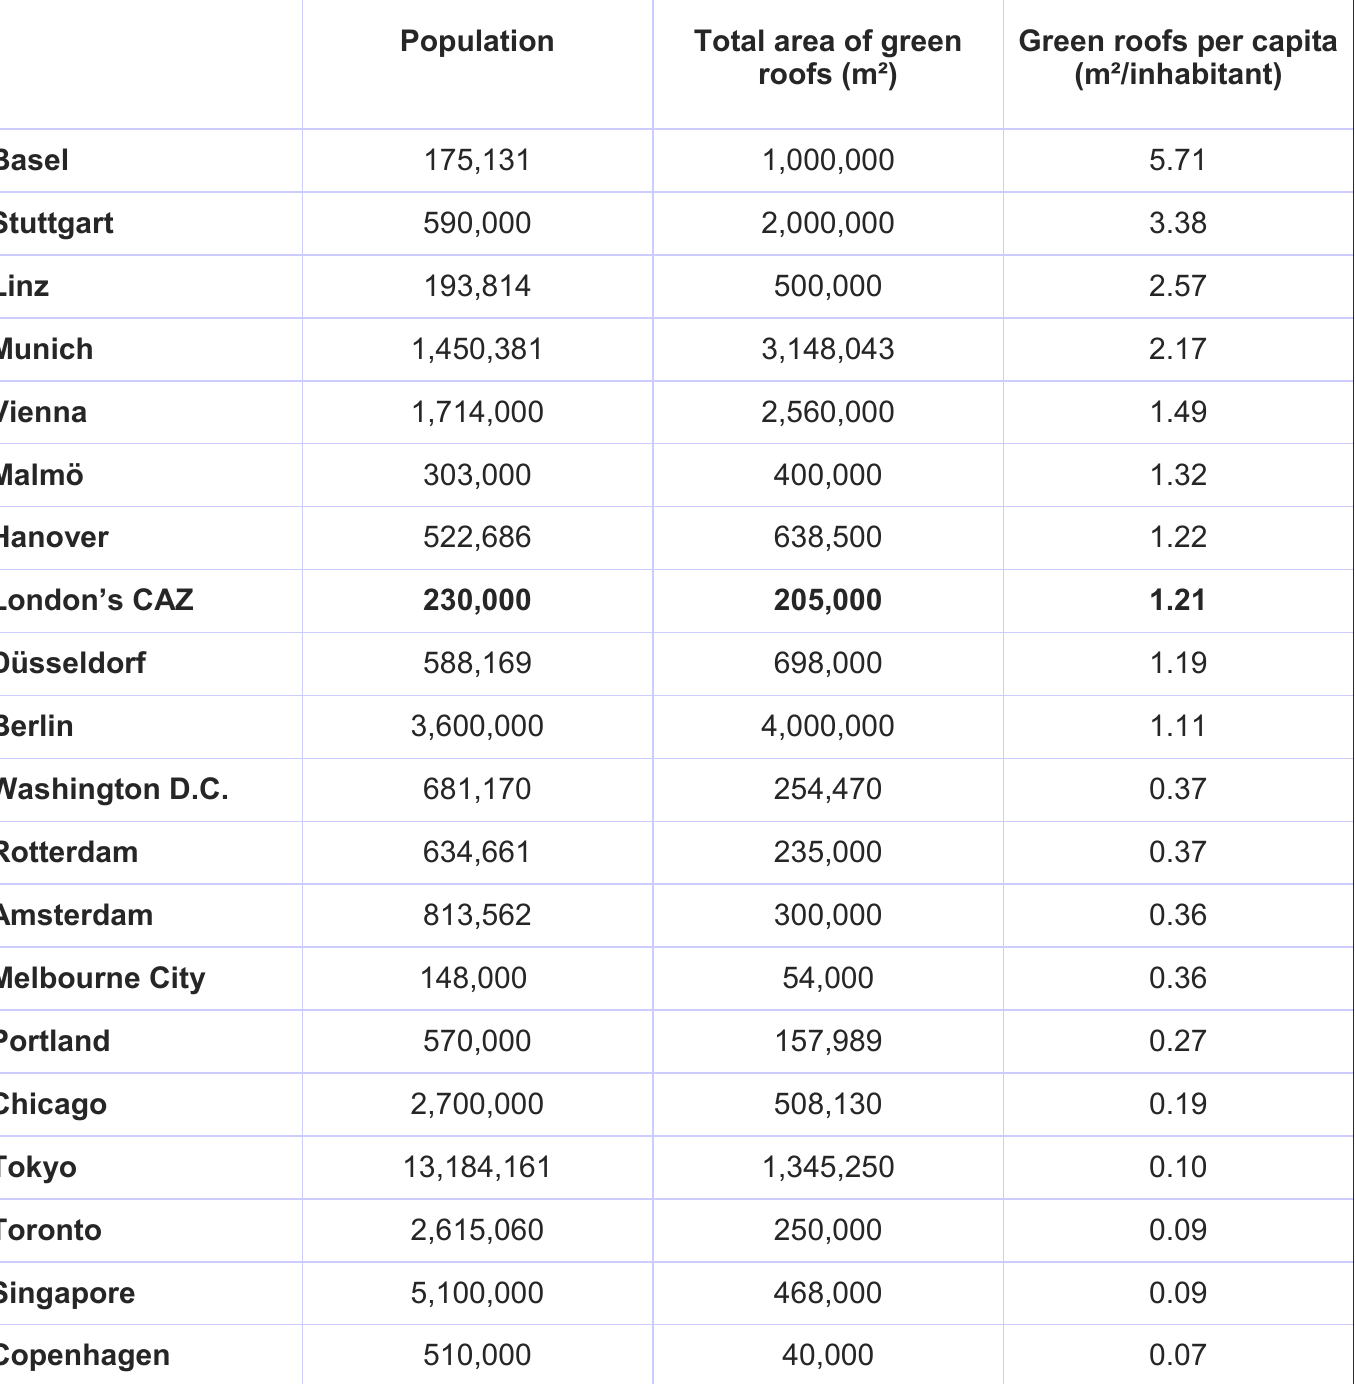
League table: Global green roof area and density, 2015 The table below ranks cities in terms of square metres of green roof per inhabitant, which is in line with the World Health Organisation’s urban health indicator of green space per urban inhabitant. This is a more appropriate metric when demonstrating how well cities are performing in terms of green roof provision. The figures reveal that while certain cities have an impressive total green roof area, the density - or sq m 2 per inhabitant - is actually relatively low. London’s CAZ, on the other hand, has a total green roof area that is slightly below the average when compared with most other cities, but has a much greater square meterage per